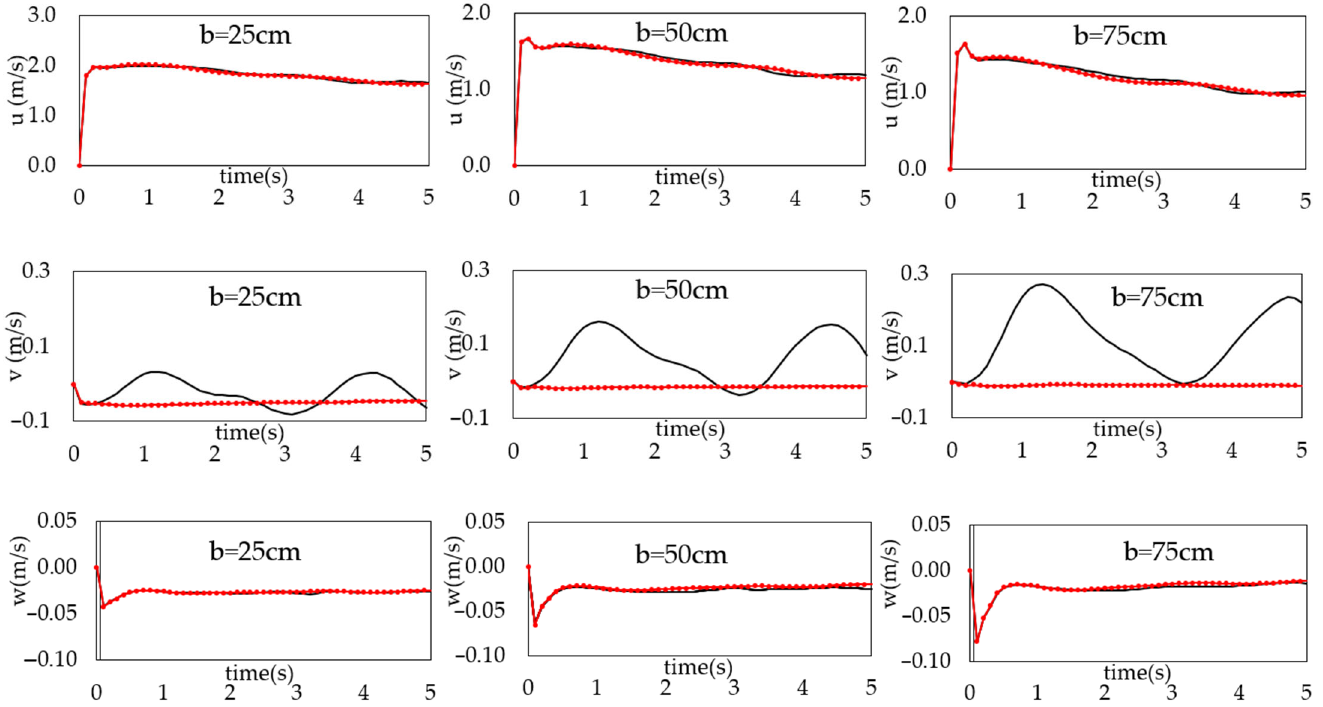
Figure 10. Near–bed velocity component profiles at the center of dam gate. Black solid line—asymmetrical dam gate; Red dotted line—symmetrical dam gate.